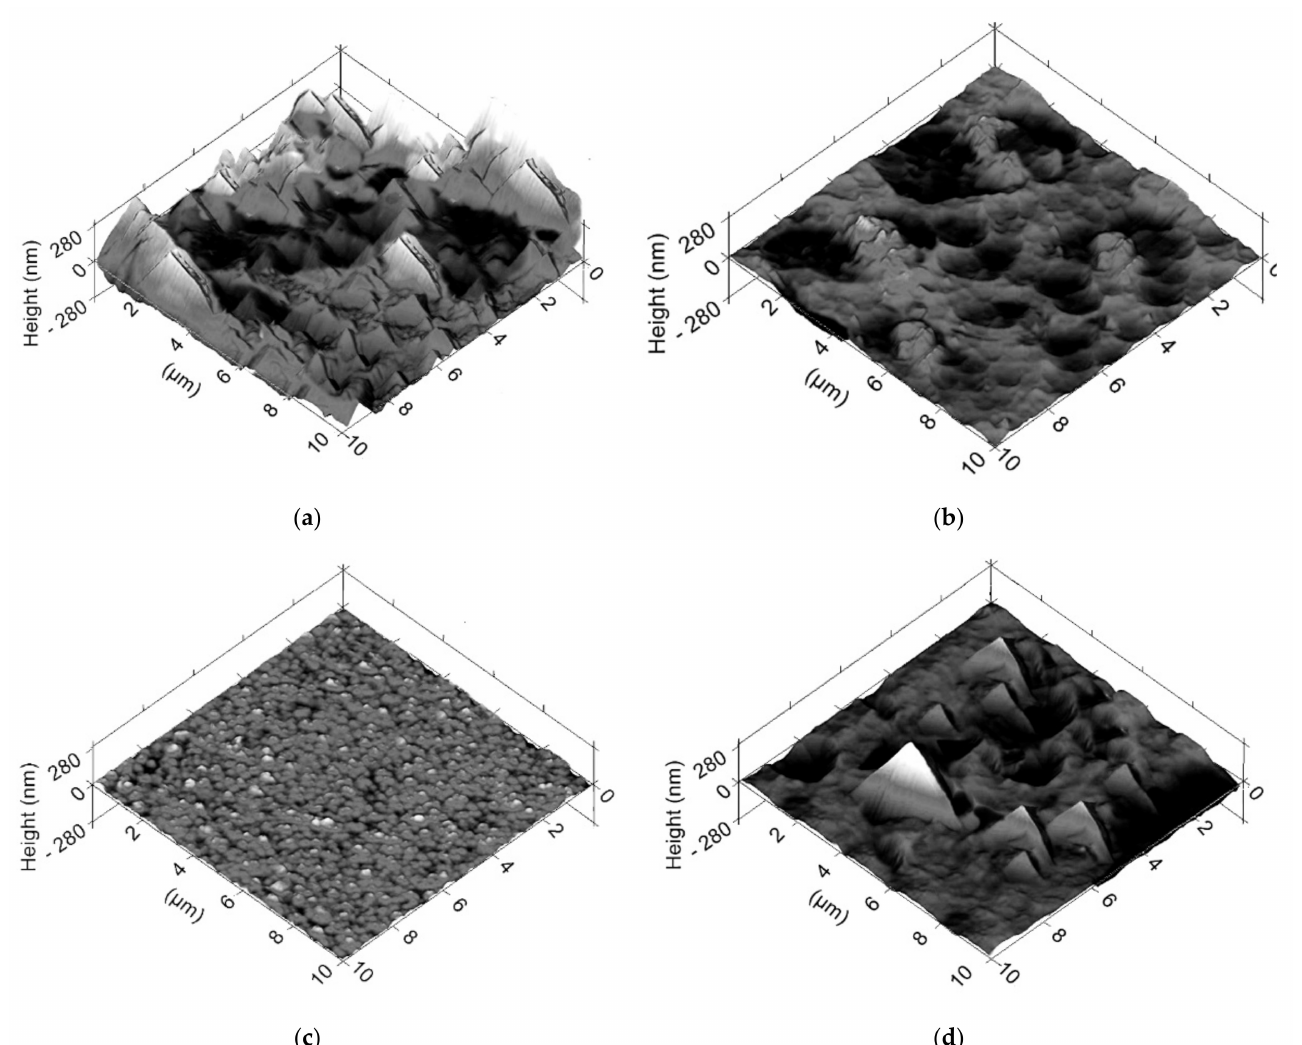
Figure 3. 3D topographic images of the SPM coatings applied to the sliding surfaces of the piston rings after the application and running-in period: ( a ) TiN, ( b ) CrN, ( c ) DLC1 and ( d )